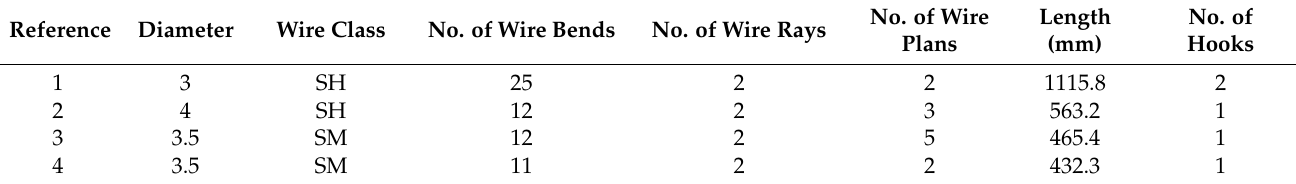
Table 2. Characteristics of the wires used in cushions